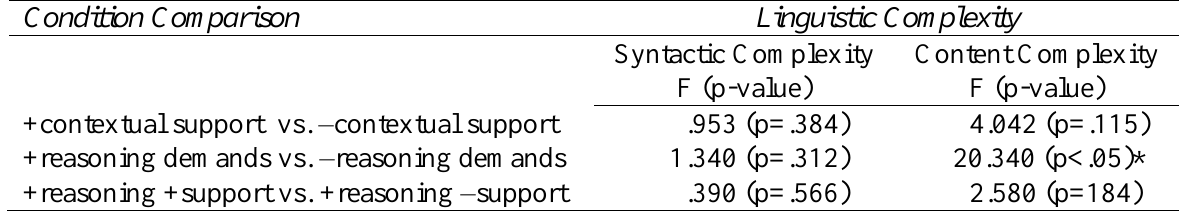
Repeated Measures Analysis for First Comparison Group